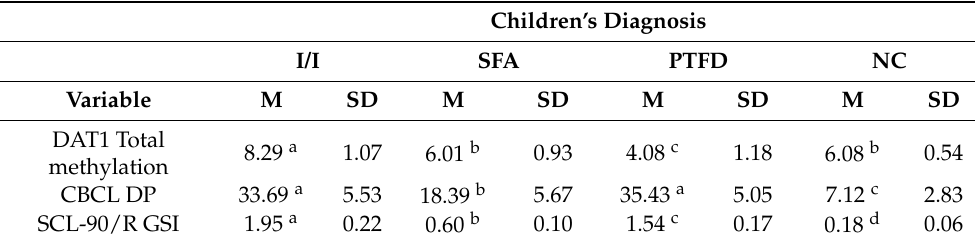
Table 2. Means (M) and standard deviations (SD) in the four